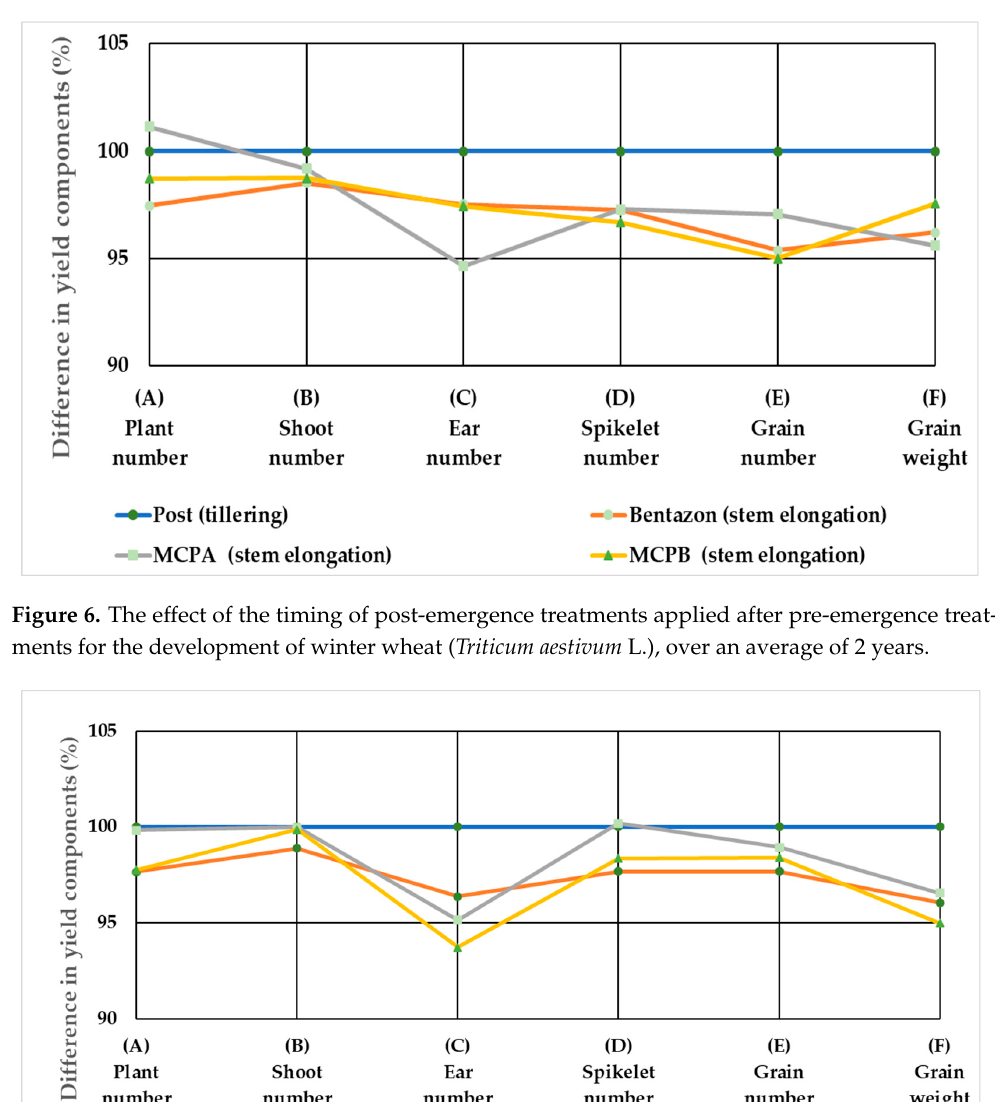
tivum L.) in post-emergence treatments at stem elongation, over an average of 2 years.